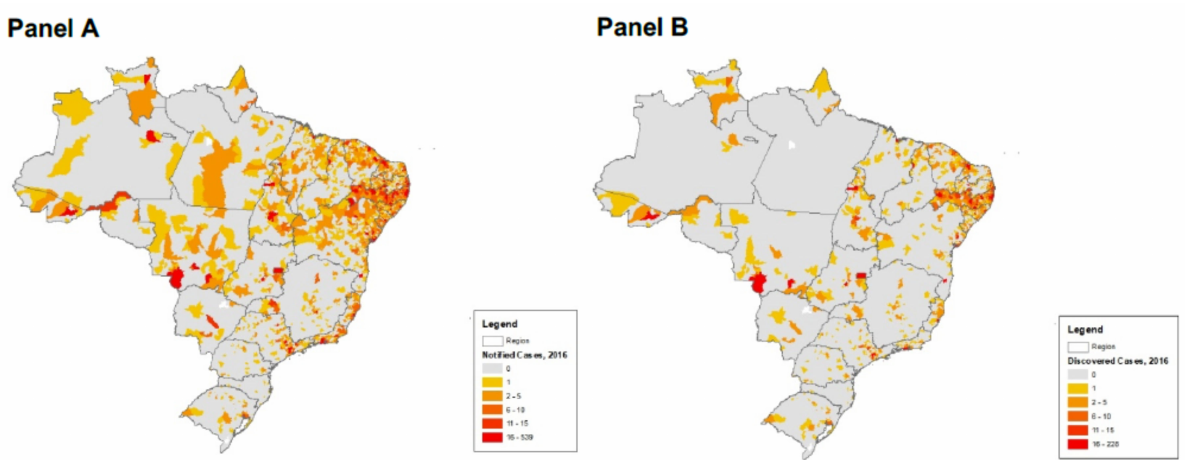
Figure 1. Geographic distribution of ZIKV incidence (Panel A ) did not match with ZIKV microen- cephaly cases (Panel B ) in the 2015-2016 ZIKV epidemic. See text for details. (Data courtesy of